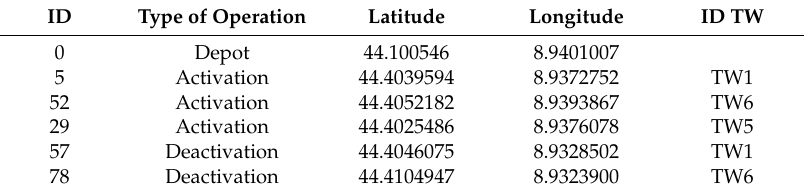
Table 2. Sample of output dataset expressed in GIS coordinates and relative TW.